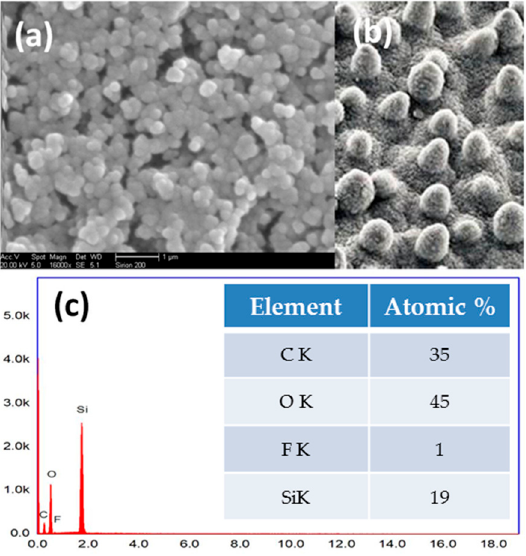
Figure 2. ( a , b ) Scanning electron microscopy (SEM) images of PDMS-SiO 2 . ( c ) Energy dispersive spectroscopy (EDS) image of PDMS-SiO 2 .